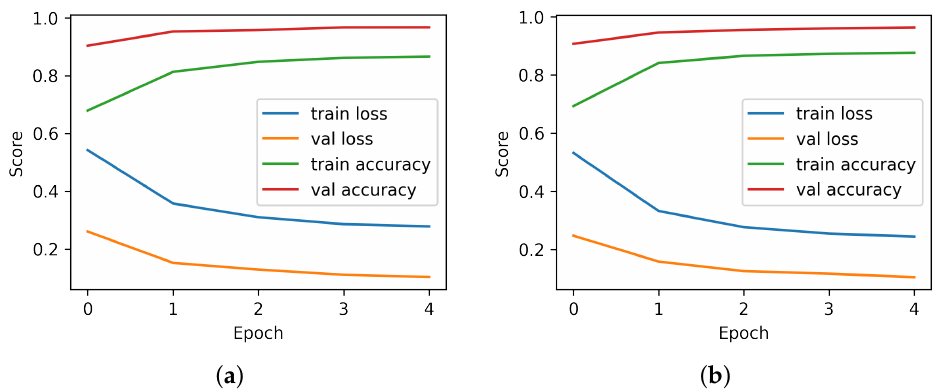
Figure 8. The time series-based performance analysis during training of deep learning-based models. ( a ) The performance analysis of the LSTM model. ( b ) The performance analysis of the GRU model.